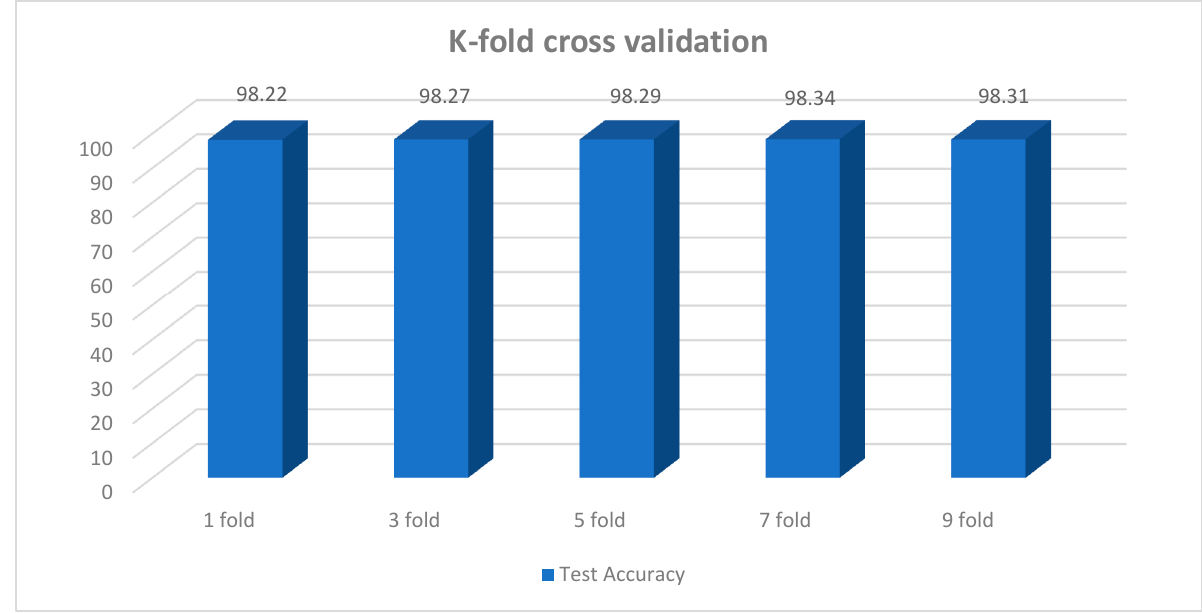
Figure 13. K-fold cross validation results.